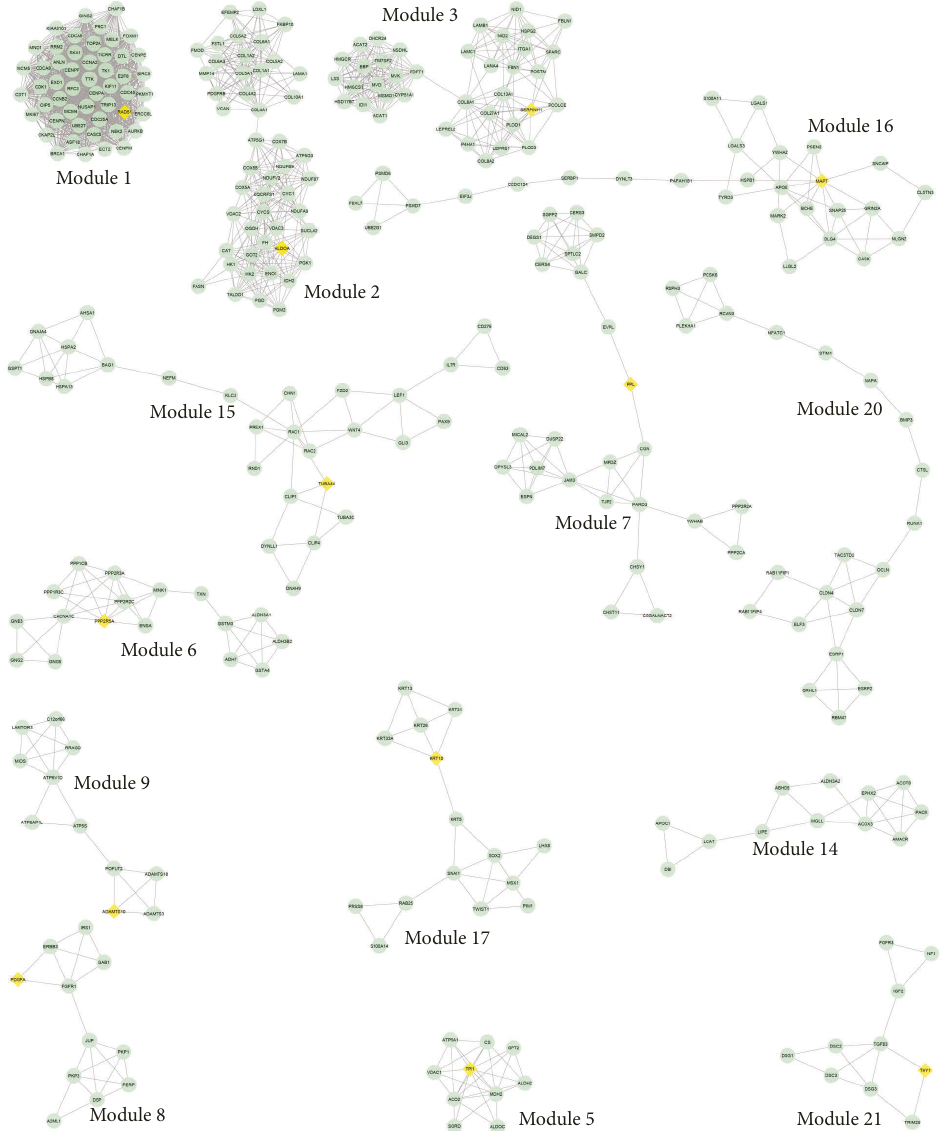
Figure 2: Clustering analysis. These modules were identified using the MCODE plugin in a PPI network based on the DEGs in ame- loblastoma compared to normal gingiva. The STRING database was the reference for the identification of interactions between proteins. The yellow circles represent the seed nodes in each cluster. PPI, protein-protein interaction; STRING, search tool for the retrieval of interacting genes; DEG, differentially expressed genes; MCODE, molecular complex detection